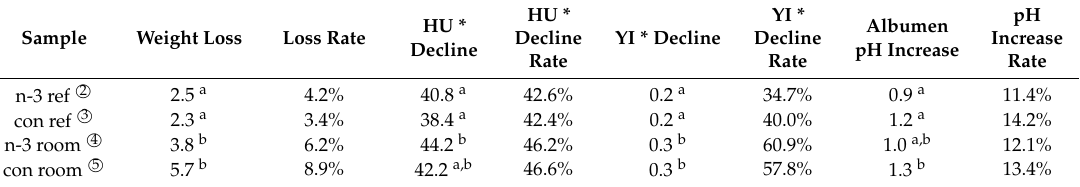
Table 4. The quality 1 (cid:13) changes of n-3 PUFAs enriched and conventional eggs under different